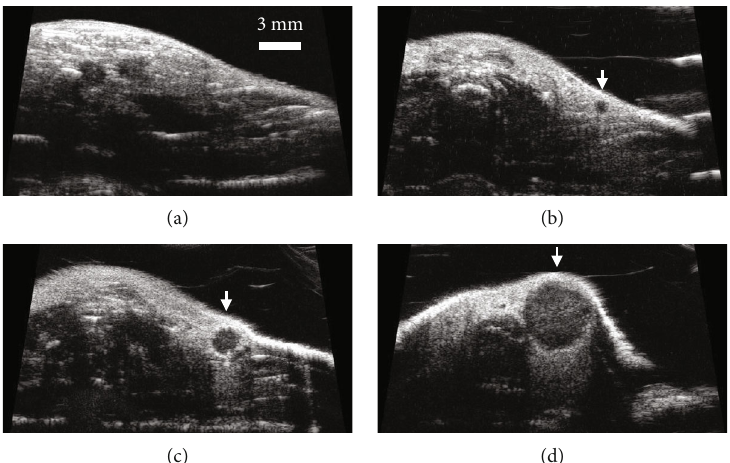
Figure 1: Frames of high frequency B-mode images acquired in the abdomen of (a) control FVB/N and tumor-bearing (b – d) C3(1)\Tag mice. The tumors shown in (b – d) are 0.8, 2.1, and 5.1mm in diameter, respectively.